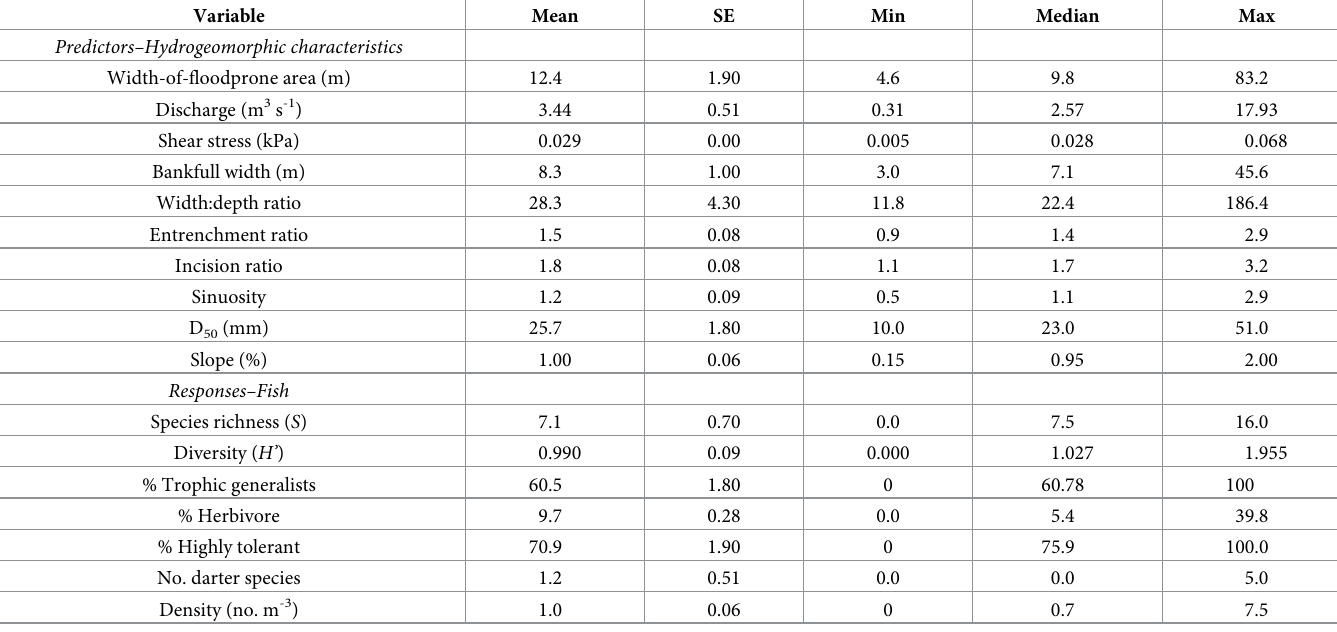
Table 3. Descriptive statistics for predictor and response